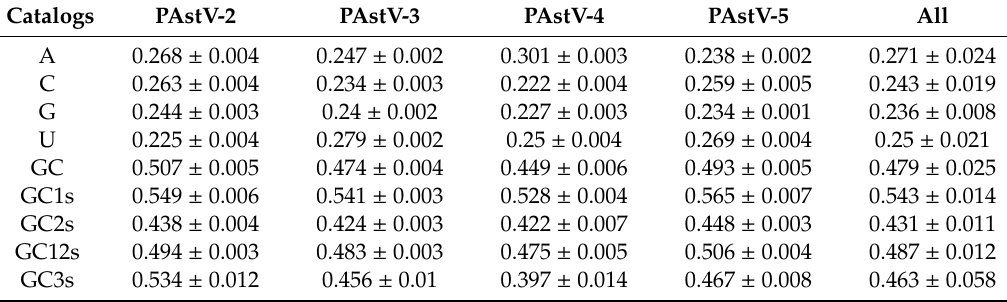
Table 1. The nucleotide composition and properties of CDS of the PAstV genomes.